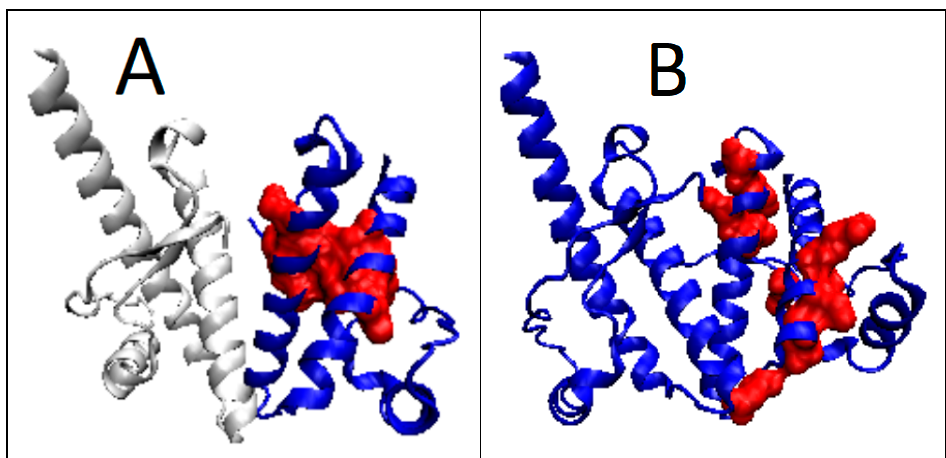
Figure 8. T, O and M profiles for the prion protein for which its structure available in PDB is dimer—4HLS. ( A ) Profiles for the chain A as it shows in dimer; ( B ) profiles for a monomer treated as an individual structural unit.